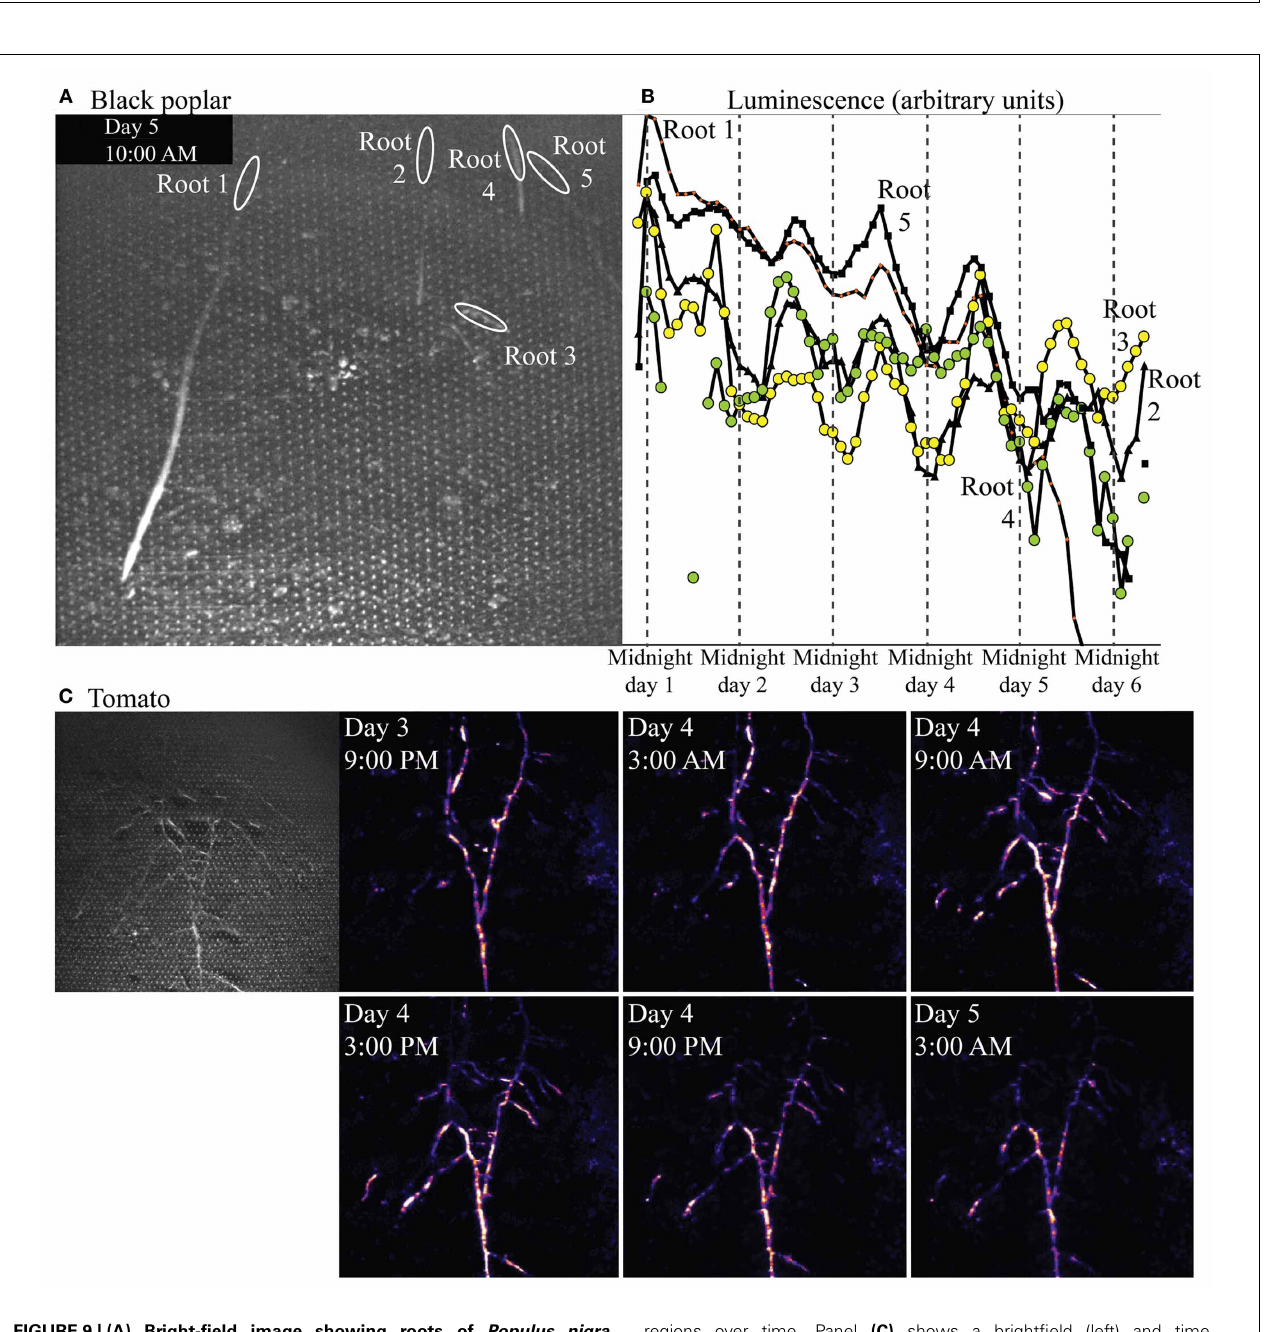
time frames. Panel (C) graphs the distance of maximum luminescence from the root tip against root growth rate. Panel (D) shows a portion of a similar image series from another corn plant, and panel (E) shows the distribution of luminescence along the root axis averaged over the 25h experiment. Panel (F) includes zoomed portions of images from the panel (D) series (indicated by i, ii, and iii), showing false-color luminescence close behind the growing root tip.